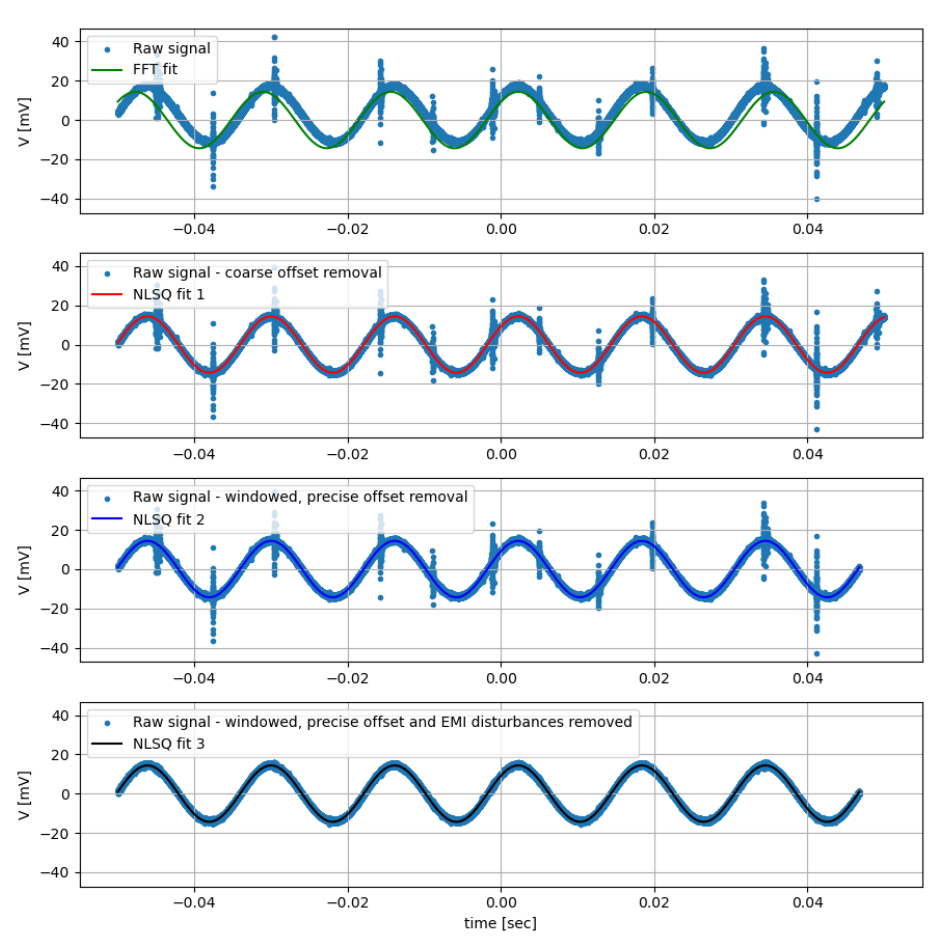
Figure 8. Example of the four steps used to recover the fundamental amplitude from an acquired